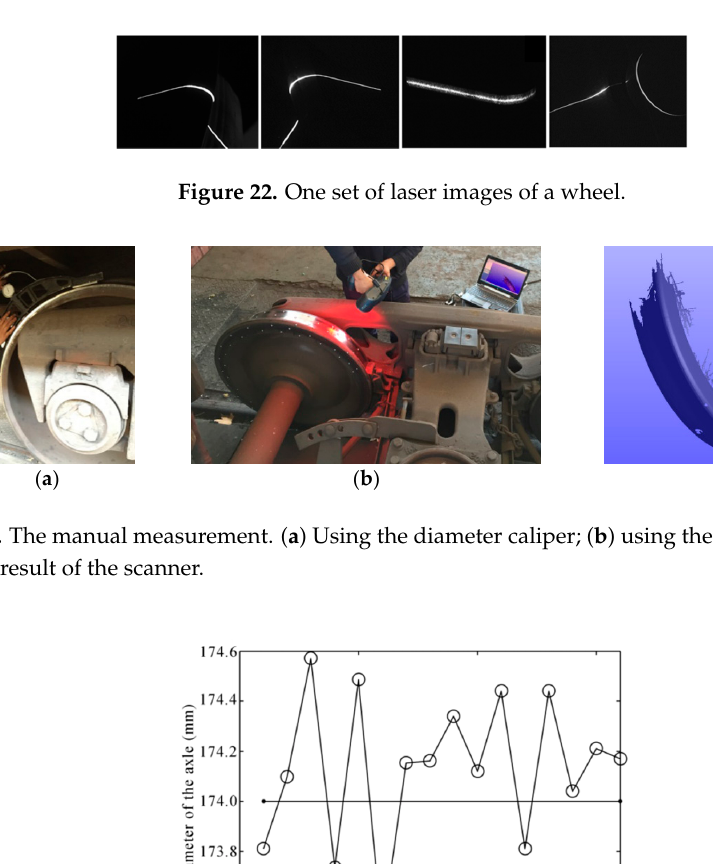
Figure 24. The diameter results of the wheelset axle.